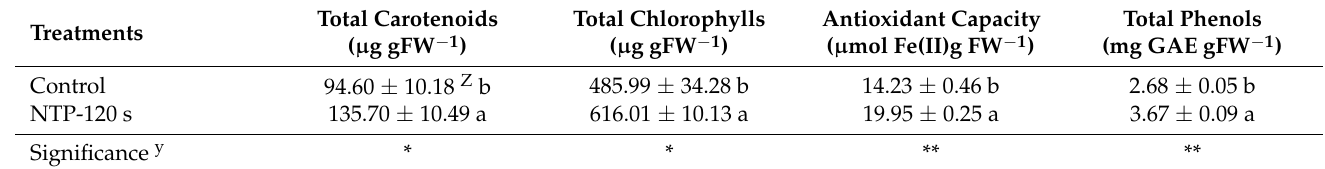
Table 3. Effect of NTP treatment (120 s every hour) of the nutrient solution on leaf content of total carotenoids, chlorophylls content, antioxidant capacity and total phenols content of baby leaf lettuce plants grown in hydroponic growing system (HGS) for nine